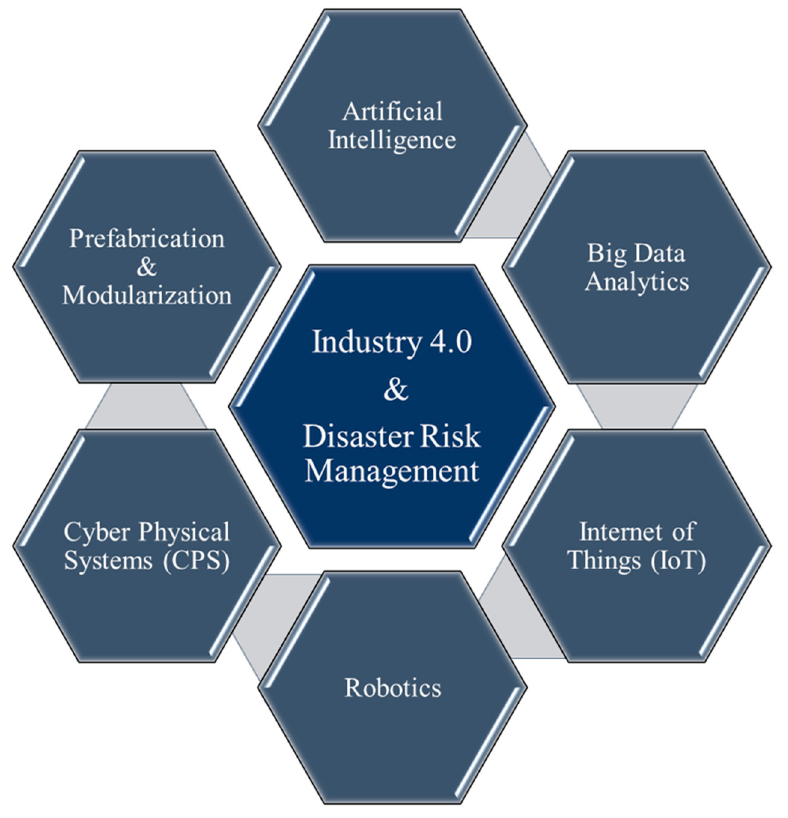
Figure 11. Summary of the findings.